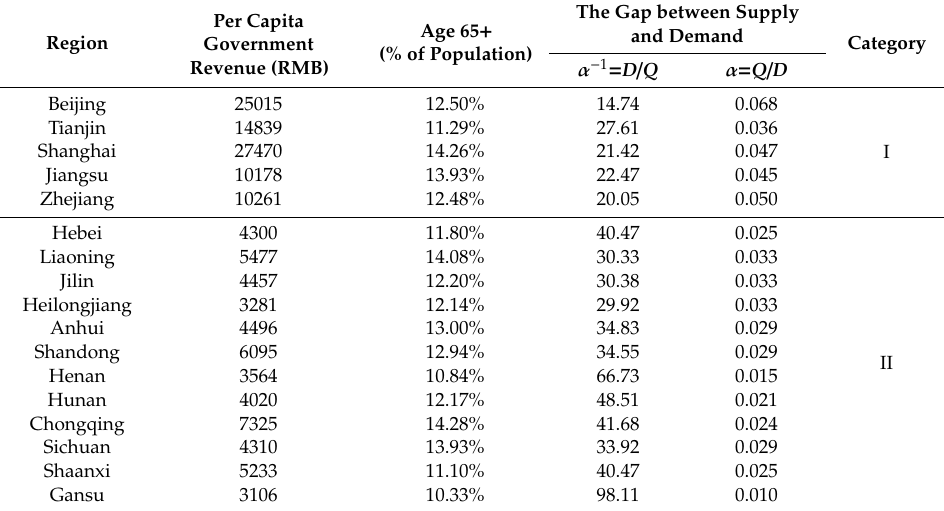
Table 1. Classification based on regional economic conditions